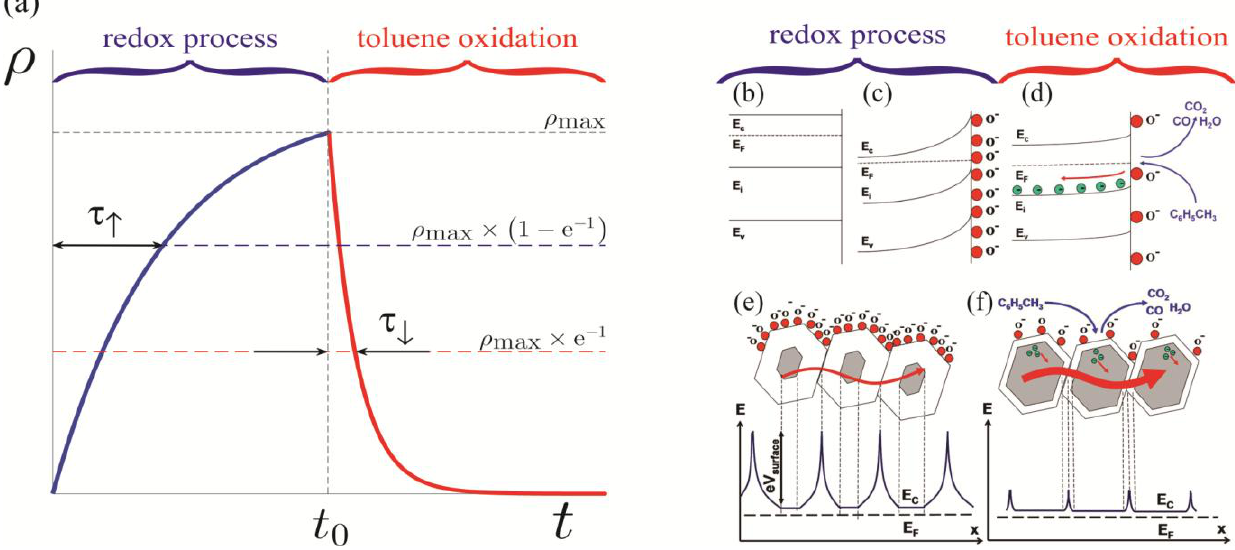
Figure 5. ( a ) Exponential ―RC-circuit‖ approximation of the sensor response. Energy level schematics ( b ) of the bulk ZnO; ( c ) at the depleted surface of ZnO; and ( d ) upon toluene oxidation on the ZnO surface (arbitrary intrinsic E levels correspond to defect states in i n-type ZnO). Schematic energy-level diagrams of the polycrystalline ZnO layer ( e ) prior to toluene exposure and ( f ) after exposure and subsequent toluene oxidation